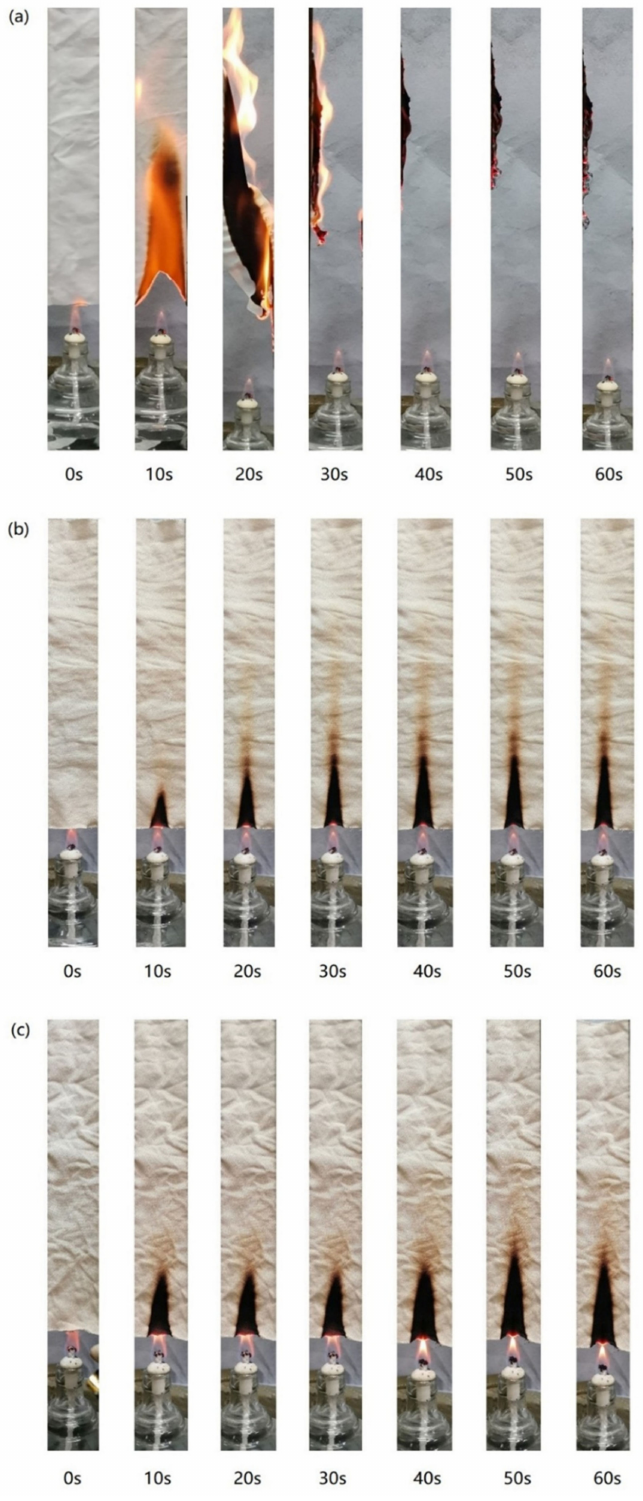
Figure 8. Vertical combustion test results of control ( a ), FR − lyocell before ( b ) and after washing ( c ). In order to better assess the flame retardant properties of modified fabrics, the LOI tests were conducted, and the detailed data are listed in Table 4. The LOI value of original fabric is 15%. In contrast, the LOI value of the FR-lyocell fabric increased to 39.5%, indicating the improved flame retardancy of the modified fabric. As a wearable fabric, its flame- retardant durability is a required index. Thus, it is necessary to test the water